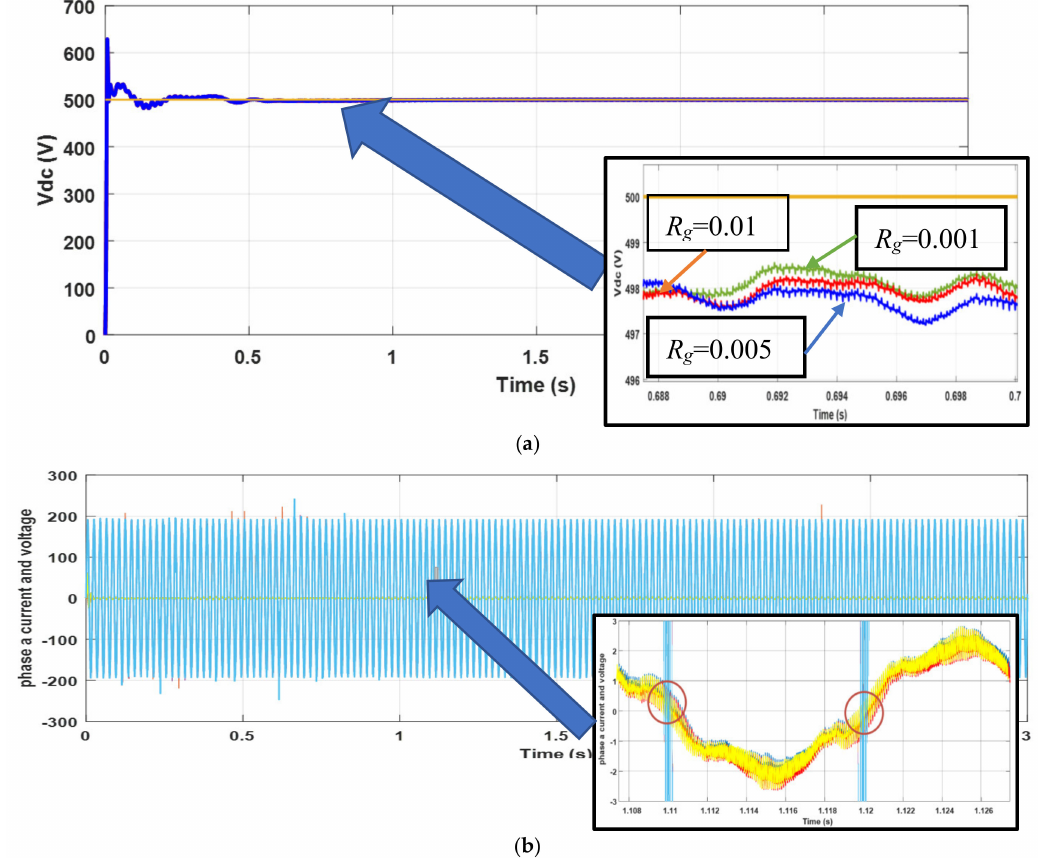
Figure A3. Grid-side converter (GSC) waveforms at varying grid filter resistance: ( a ) DC-link voltage, ( b ) grid